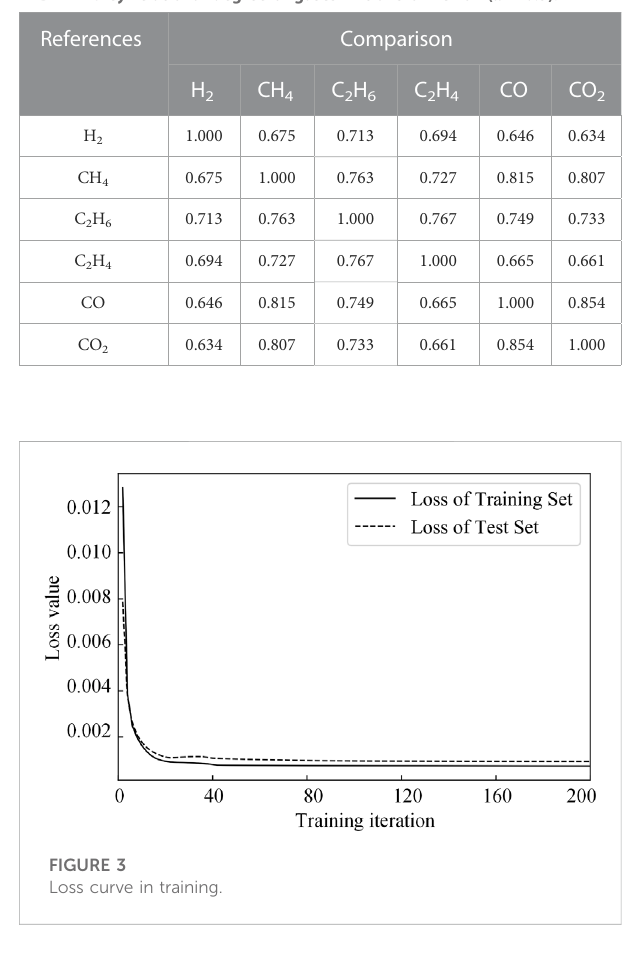
TABLE 1 Grey relational degree of gases in transformer oil ( α = 0.5).